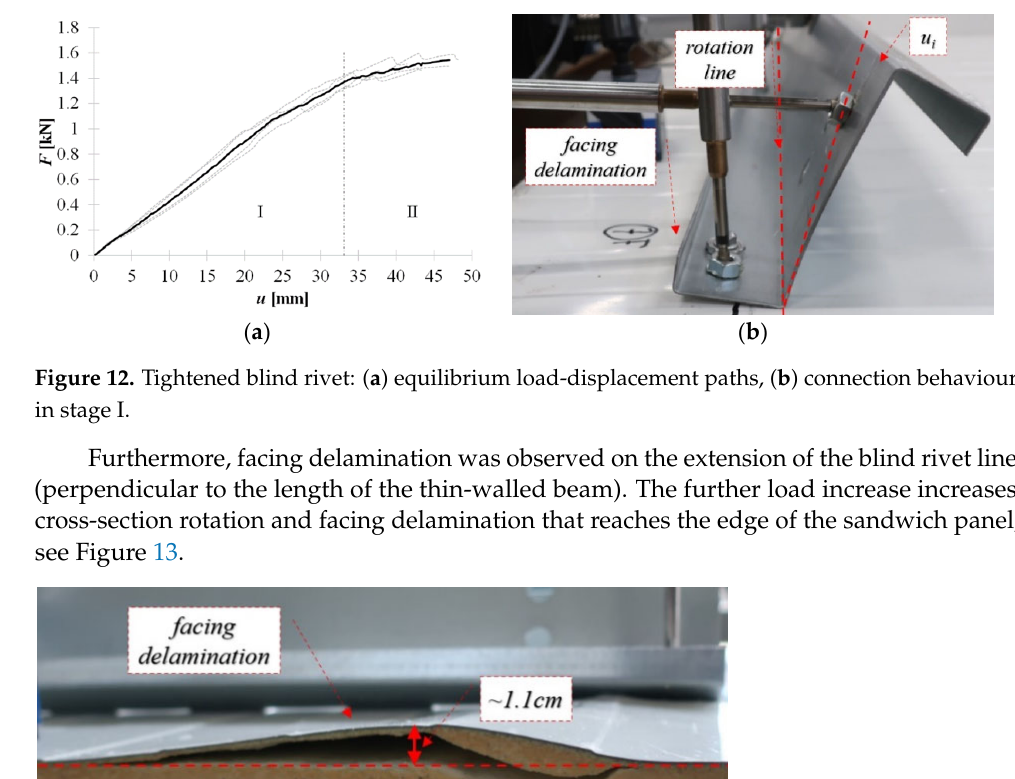
Figure 13. Tightened blind rivet–facing delamination in stage II.